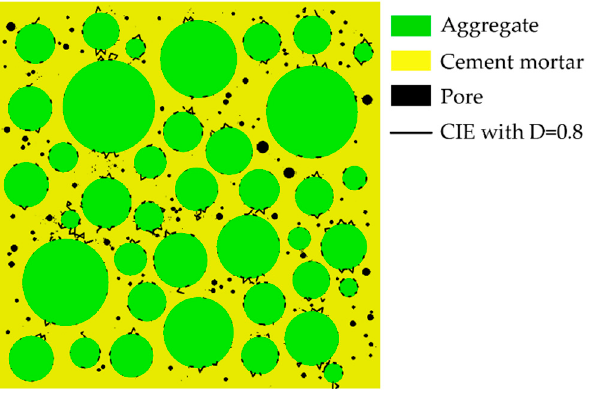
Figure 13. The distribution of the CIEs with D = 0.8 when σ / σ max ≈ 0.94 ( ε > ε p ).